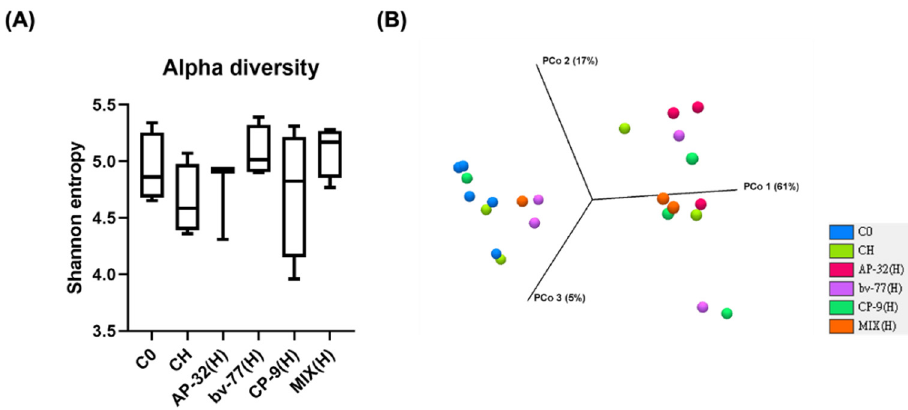
Figure 4. The diversity of the gut microbial composition was not significantly affected by 8-week probiotic treatments. Gut microbiota were analyzed by 16S rRNA amplicon sequencing in SD rats after probiotic treatments for 8 weeks. ( A ) The Shannon diversity index (mean ± SEM) of the microbial community was analyzed in blank control (C0), symptom control (CH), and probiotic groups. ( B ) The beta diversity of the gut microbial community was presented by the PCoA plot at the OTU level on week 8 with a weighted UniFrac distance derived from 16S rRNA sequencing data. No significant difference was seen between each group. MIX: probiotic mixture of AP-32, bv-77, and CP-9; H = 2.5 × 10 10 CFU/kg/day.